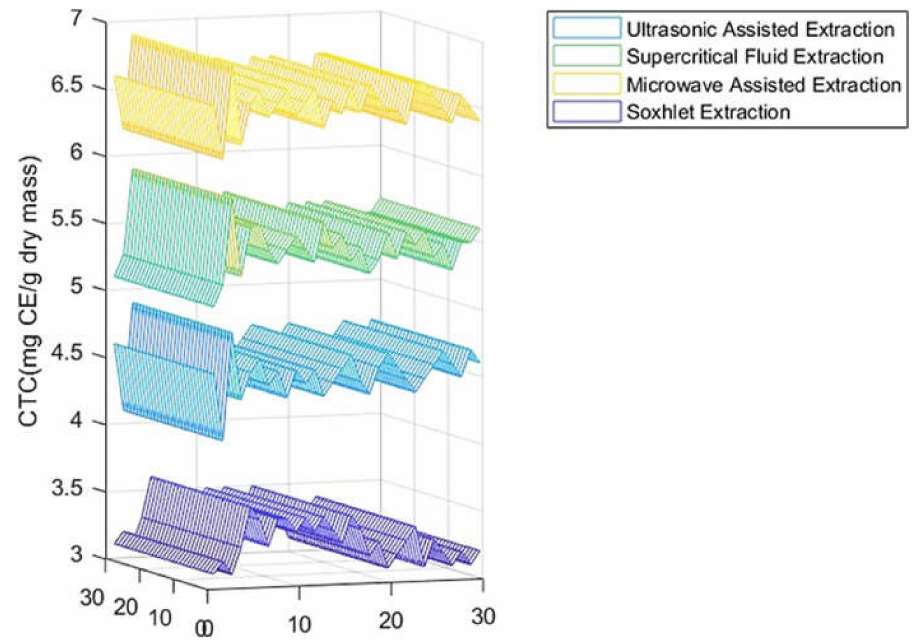
Figure 3. CTC of carob pod extracts using different extraction